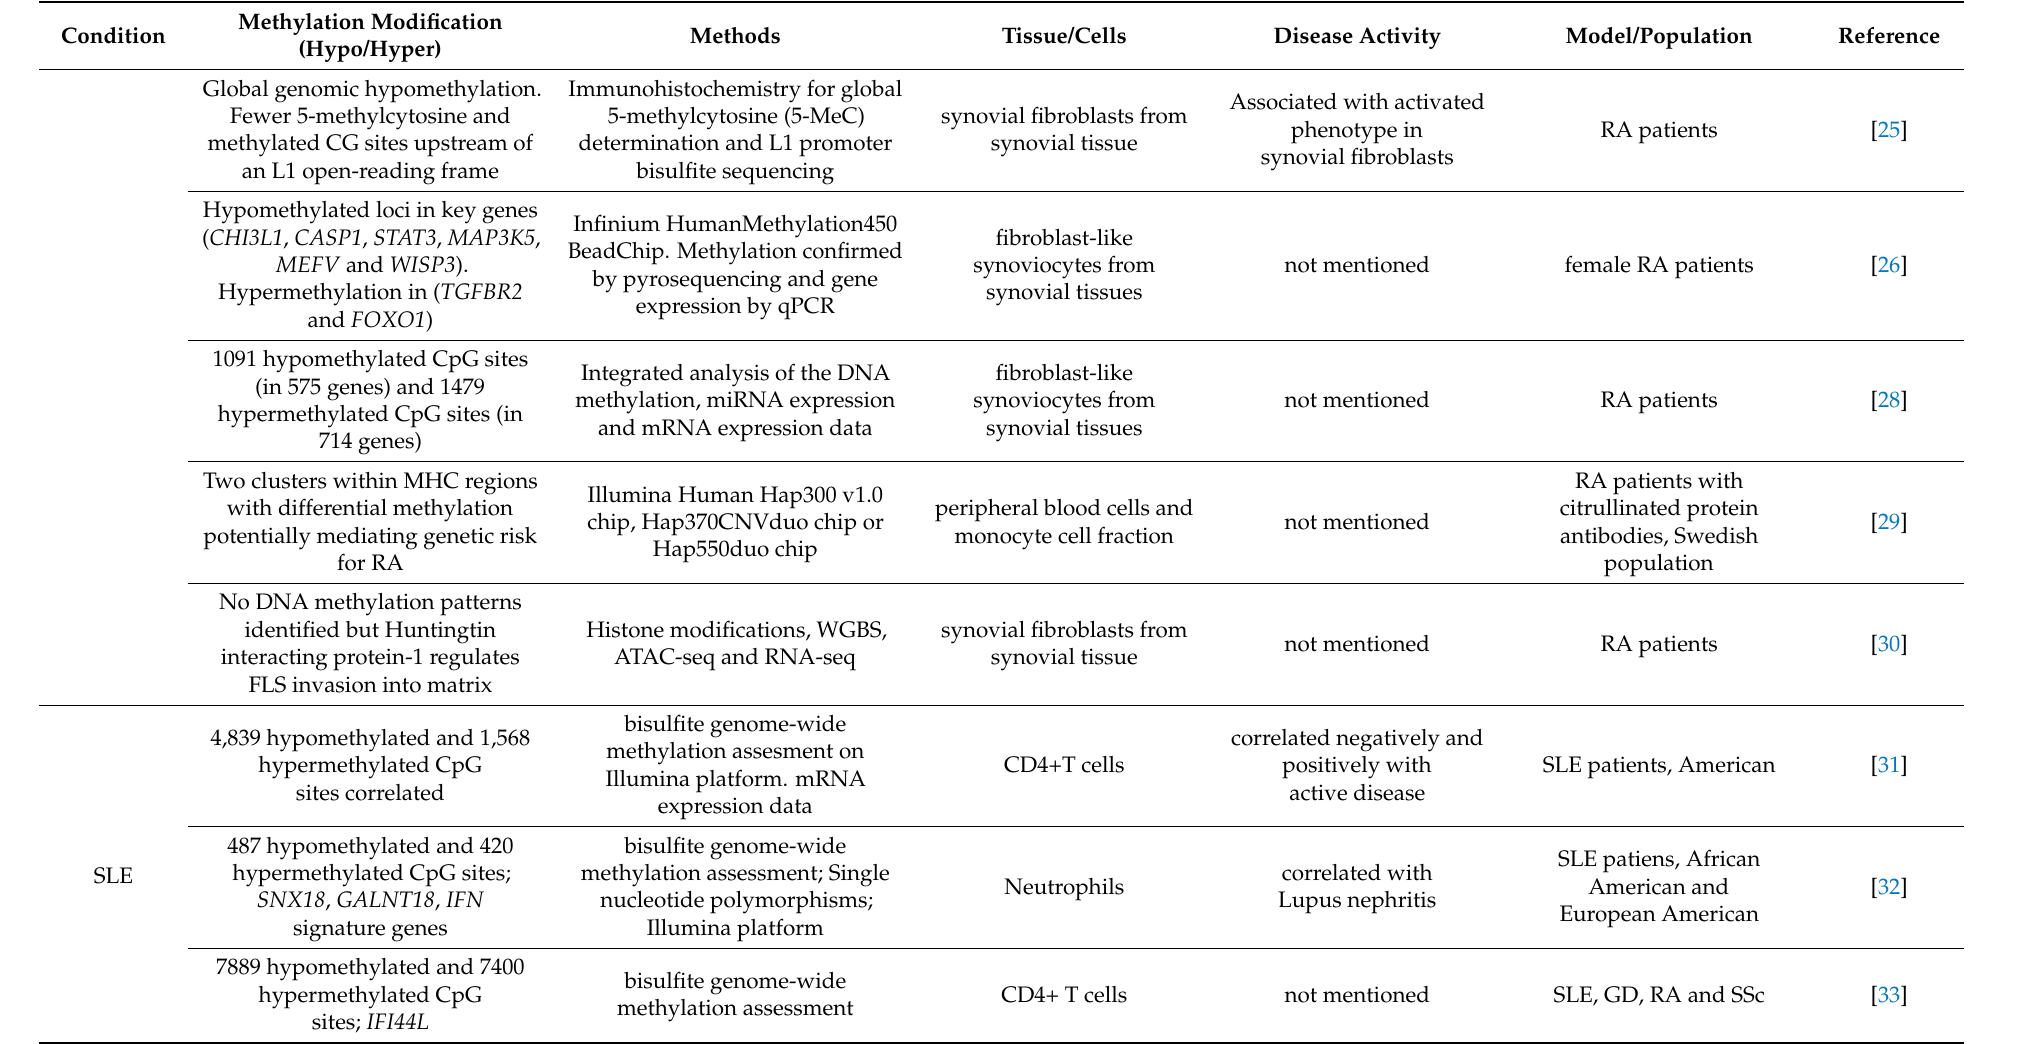
Table 1. Methylation studies in autoimmune